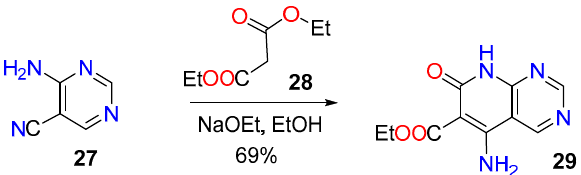
Figure 13. Synthesis of the 5-amino substituted pyrido[2,3- d ]pyrimidin-7(8 H )-one ( 29 ) from the nitrile substituted pyrimidine ( 27 ) . substituted pyrimidine ( 27